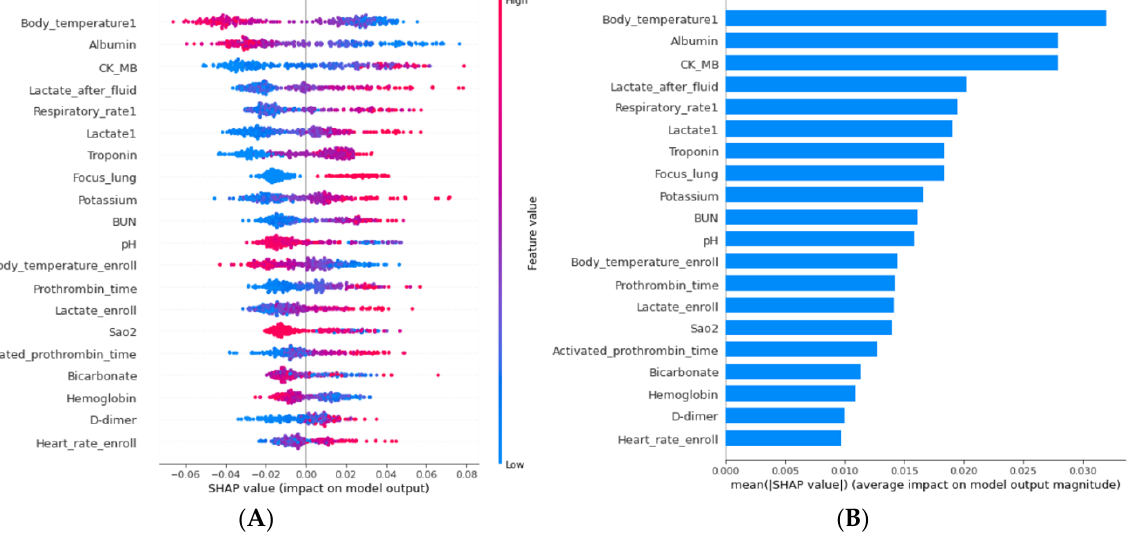
Figure 3. Summary of feature effects in the BRF model. ( A ) Overall effects of the top 20 variables. ( B ) Beeswarm plots showing the top 20 variables’ effects for all patients; Body_temperature1, initial body temperature; Lactate_after_fluid, lactate level following fluid administration; Respiratory_rate1, initial respiratory rate; Lactate1, initial lactate level; Focus_lung, lung as the site of infection; BUN, blood urea nitrogen level; pH, initial pH on arterial blood gas analysis; Body_temperature_enroll, body temperature when septic shock is recognized; Lactate_enroll, lactate level when septic shock is recognized; SaO2, initial arterial O2 saturation on arterial blood gas analysis; Heart_rate_enroll, heart rate when septic shock is recognized. All other variables are the first test values after the emergency department visit unless otherwise specified.